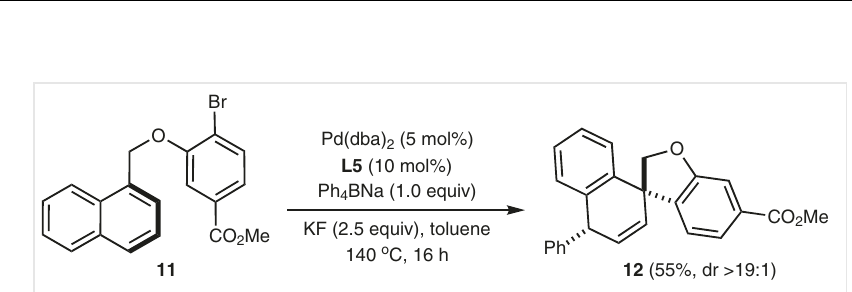
Fig. 4 1,4-Diarylation of arylether tethered naphthalene 11. Reaction conditions: 11 (0.2 mmol), Pd(dba) 2 (0.01 mmol), L5 (0.02 mmol), Ph 4 BNa (0.2 mmol), KF (0.5 mmol), toluene (2 mL), 140 °C, 16 h, isolated